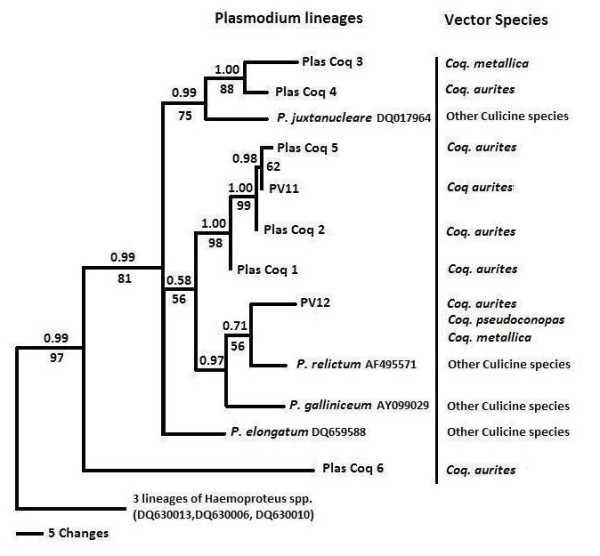
Bayesian phylogeny of the 8 lineages of Plasmodium mitochondrial cytochrome b gene obtained from Coquillettidia species, 4 lineages from published sequences of avian Plasmodium and three lineages of Haemoproteus spp. as outgroups. Names of the lineages and GenBank accession numbers of the sequences are given after the species names of parasites. Bayesian support are indicated above the branches while ML Bootstrap support, based on 100 replications are shown below the branches. The vector species in which the parasites were found (including parasites already known) is indicated under 'Vector Species.'